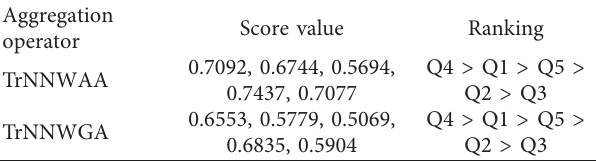
Table 2: Results of the MDM approach based on the TrNNWAA and TrNNWGA operators and the score function